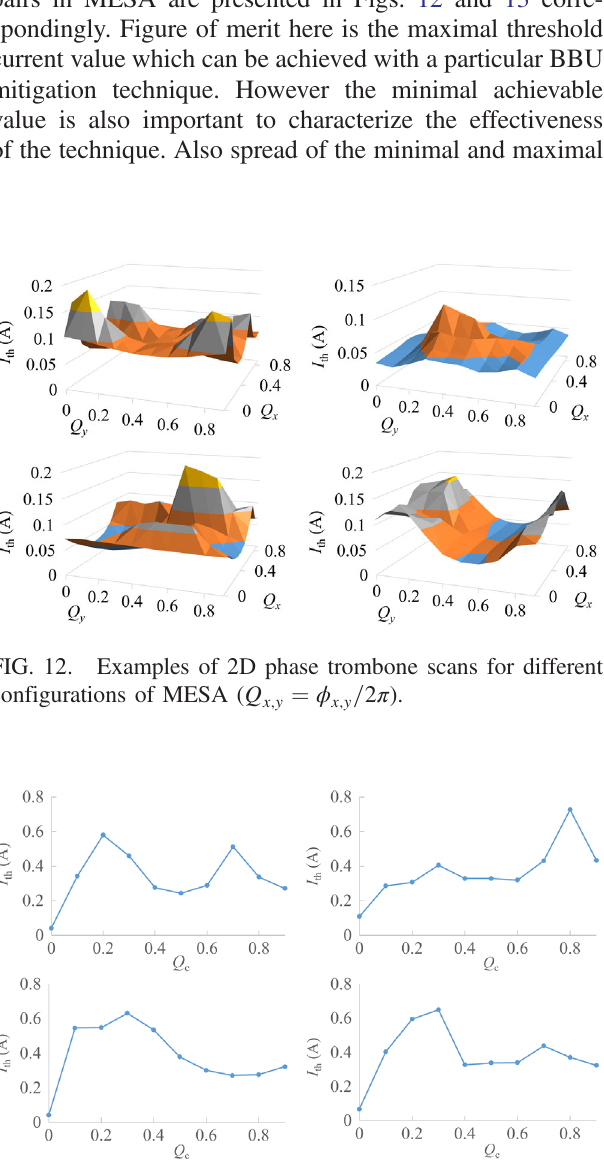
FIG. 13. Examples of 1D beam rotator scans for different configurations of MESA ( Q c ¼ ϕ c = 2 π